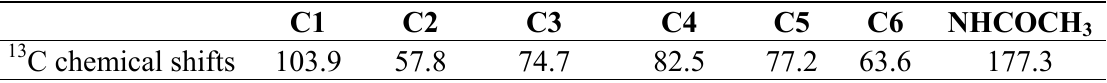
Table 1. Chemical shifts of carbon belonging to the chitin backbone